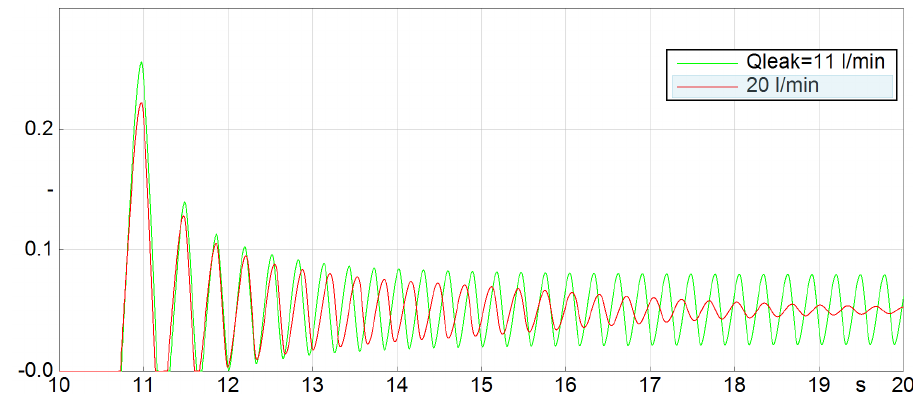
Figure 10. Valve displacement y 1 step responses for various leakage Q leak with a stepwise increase of the area of metering valve 8 at the constant values of areas of throttles 10 and 11, and outlet cavity stiffness ( A th 1 = A th 2 = 1.77 mm 2 , β out = 3.3 · 10 − 3 ).